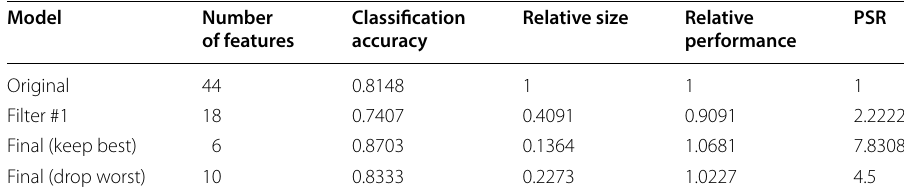
Table 12 SPECTF example